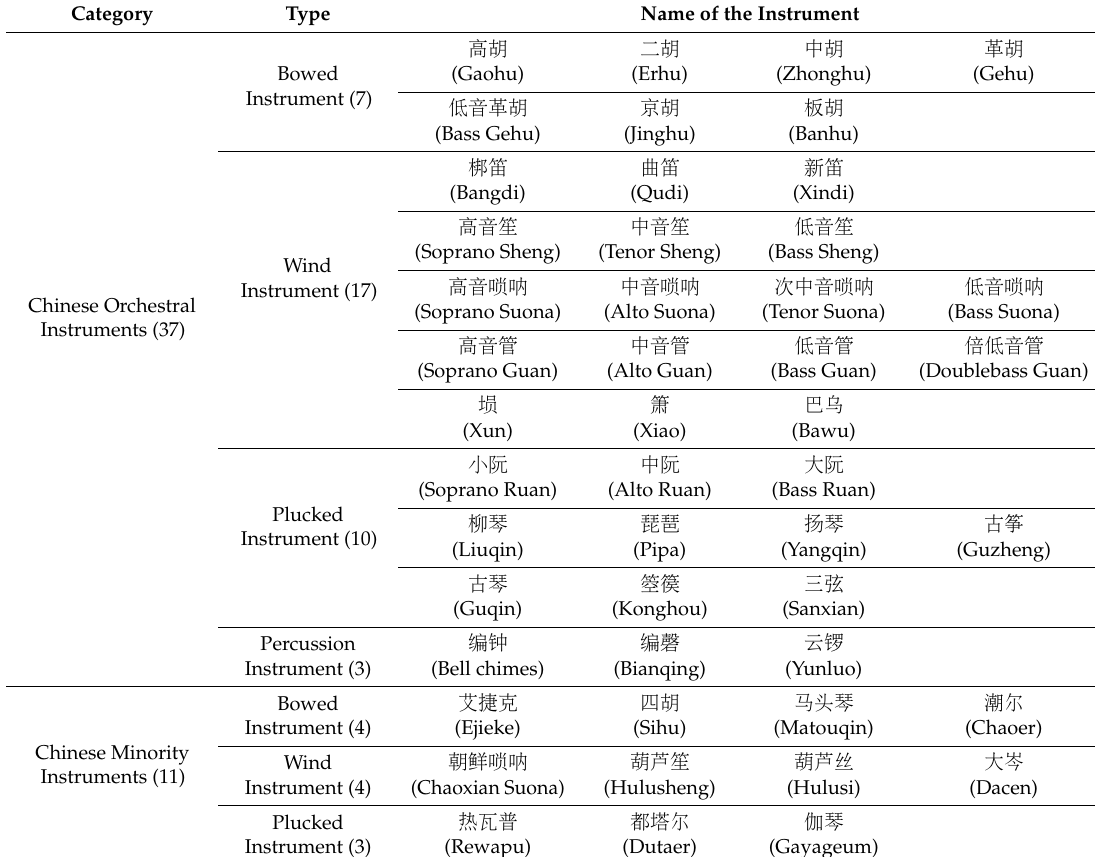
Table A1. Instrument